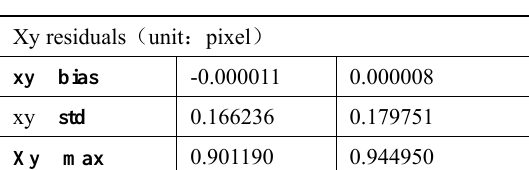
Figure 5. DSM automatically extracted from initial aerial images (in left image, red areas are point with no